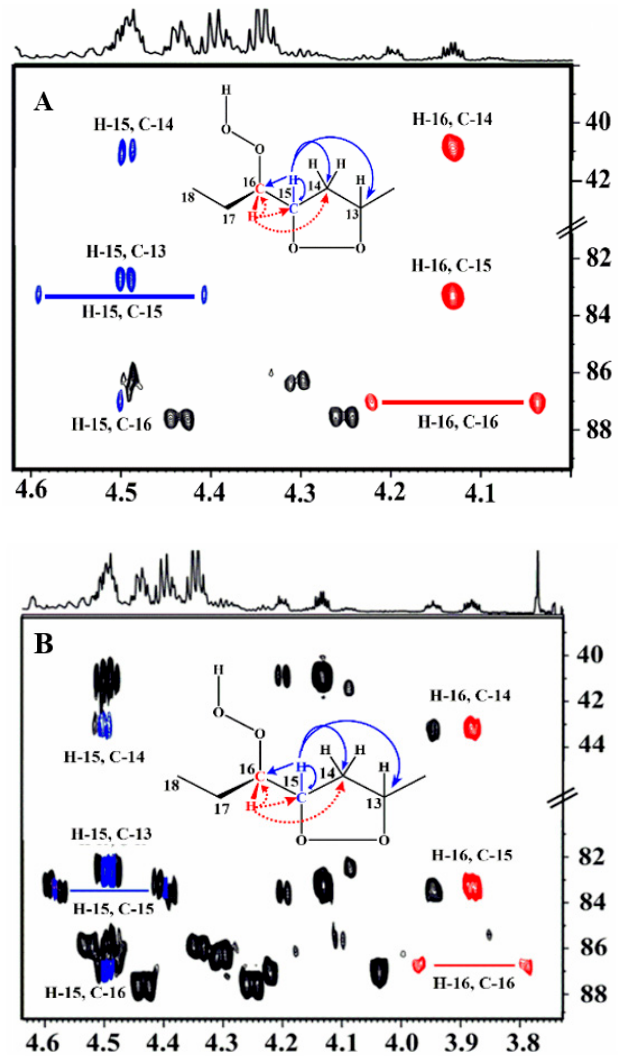
Figure 4. 1 H- 13 C HMBC correlations showing the assignments of the two diastereomeric 9- cis, 11- trans -16-OOH endo -hydroperoxides of methyl linolenate with OOH and CH-OOH resonances at 9.50 ppm and 4.3 ppm, respectively ( A ), and 9.08 ppm and 3.87 ppm, respectively ( B ). The critical connectivities of the H-15 with C-14, C-13, C-15 ( 1 J ( 13 C, 1 H)), C-16, and connectivities of H-16 with C-14, C-15, and C-16 ( 1 J ( 13 C, 1 H)) are illustrated.